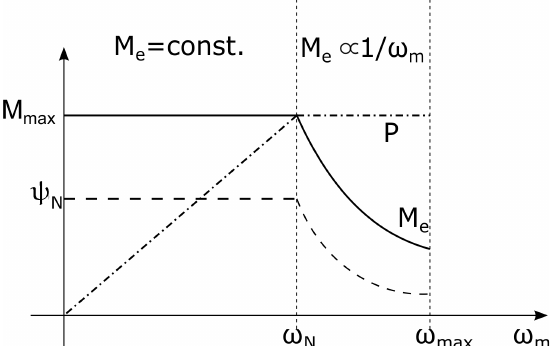
Figure 2. Theoretical two-zone angle velocity control of PMSM. The control zones shown in Figure 2 represent different types of electric motor operation: Zone 1: means working for constant torque M e = const and then the active power trans- ferred to the working machine increases linearly as the angular speed increases ( P m = M e ω m ). This zone means also working with limited current and constant flux value in the air